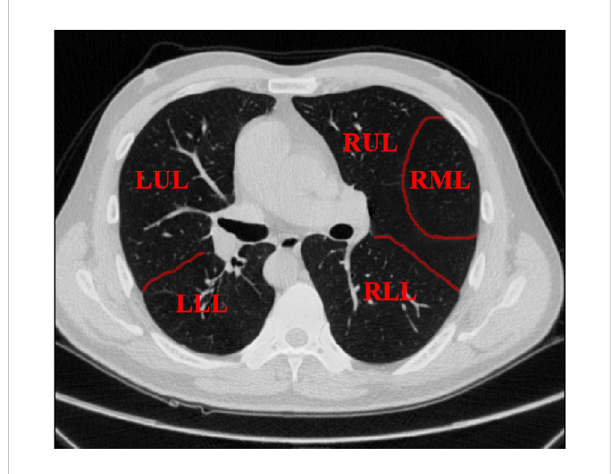
FIGURE 1 Diagram of lung lobe